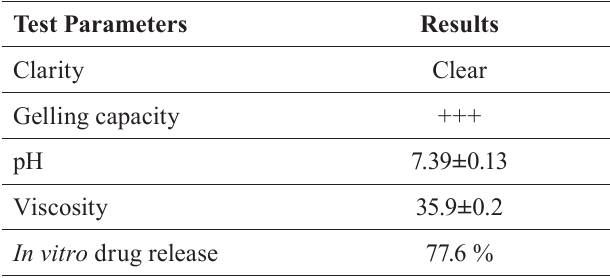
TABLE VI - Stability test Test Parameters